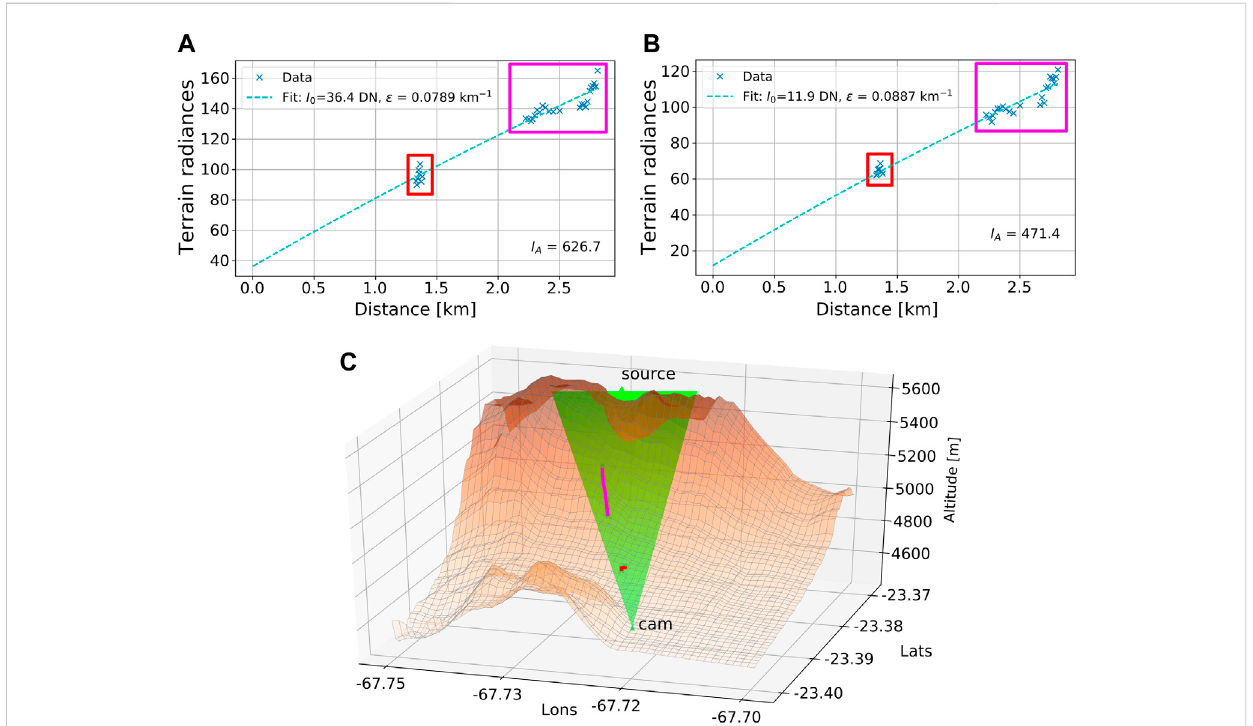
FIGURE 7 Image-basedlightdilutionprocessing. (A) On-bandimageextinctioncoef fi cientcalculation. (B) Off-band imageatmosphericextinctioncoef fi cient calculation. (C) Digital elevation model of the camera viewing geometry on Lascar volcano; camera fi eld of view is displayed in green. Magenta and red lines indicate the location of the extracted lines in the image in relation to the topography. Data points from these lines are outlined in A and B by their respective